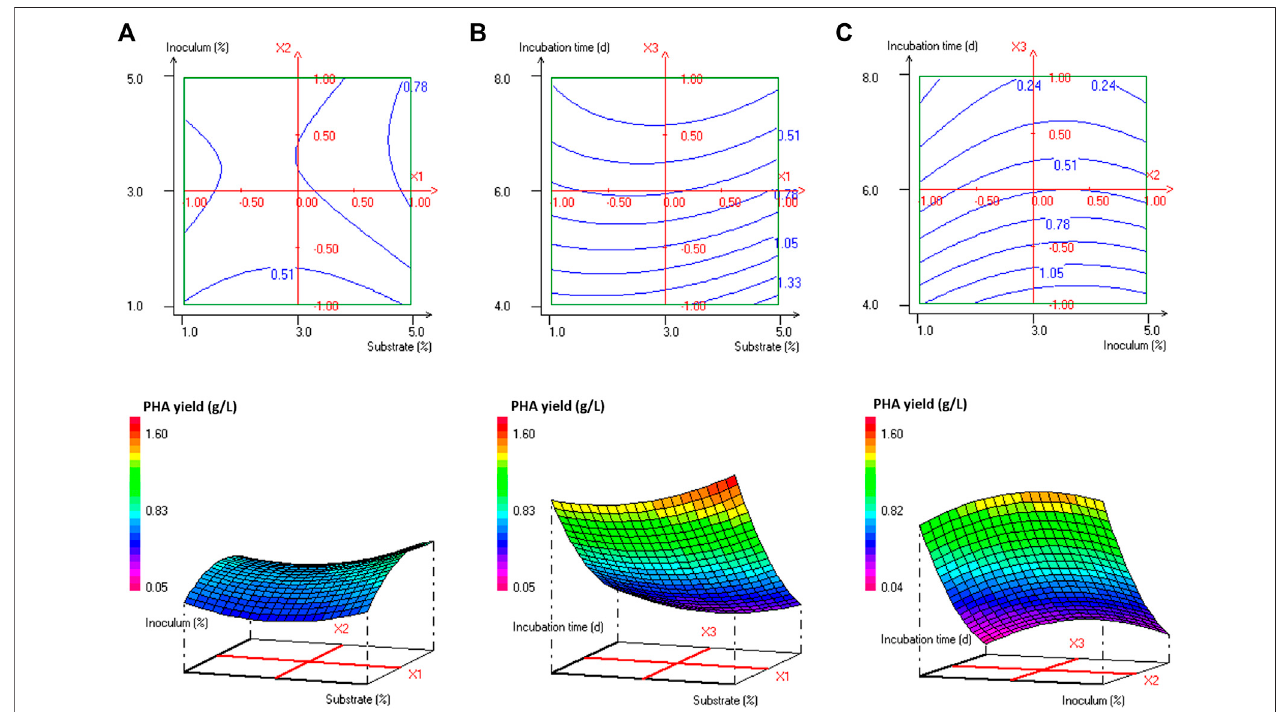
FIGURE 2 | Response surface and contour plots illustrating the effect of (A) substrate concentration and inoculum size at 6 days ’ incubation time, (B) substrate concentrationandincubationtimeat3%inoculumsize,and (C) inoculumsizeandincubationtimeat3%substrateconcentrationonPHAproduction(g/L)by H.desertis G11 using glycerol as substrate.